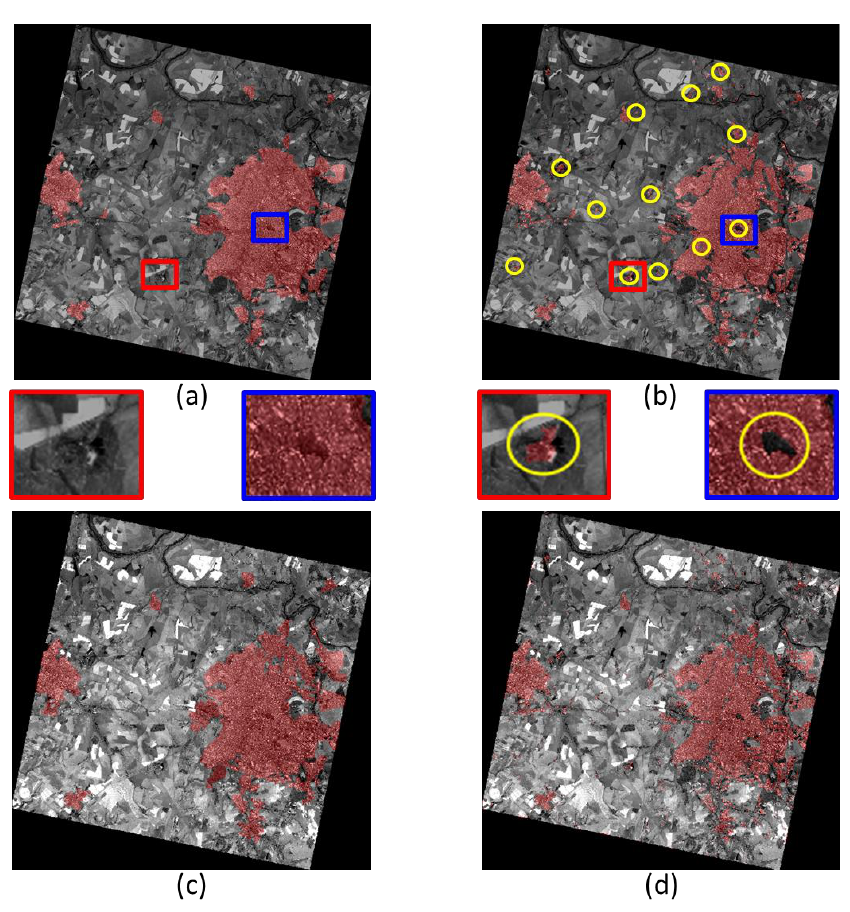
Figure 3. Ribeirao Preto test site: ( a ) first reference data set superimposed to the original CBERS-2B scene; ( b ) second reference data set; ( c ) results of the proposed procedure matching the first reference data set; ( d ) results of the proposed procedure matching the second reference data set.